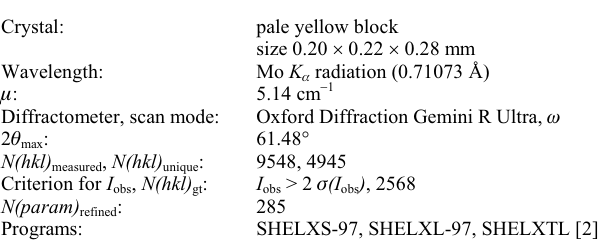
Table 1. Data collection and handling.